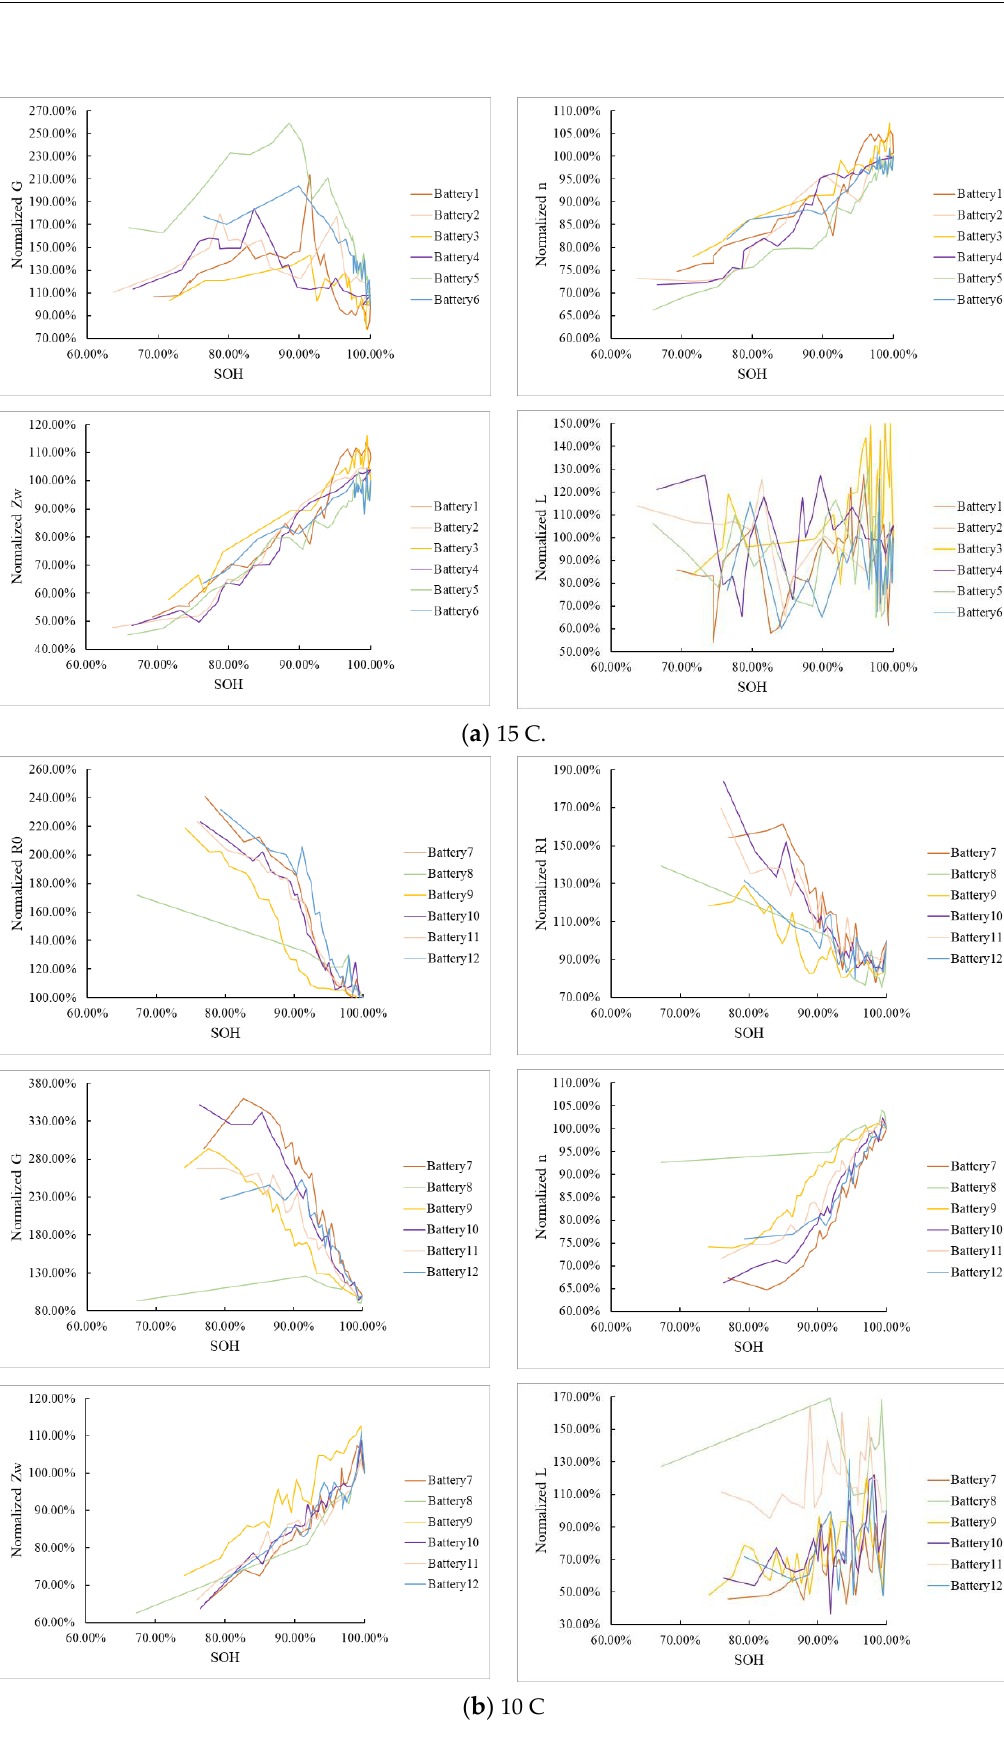
Figure A2. The relationship between the SOH and six normalized battery parameters (normalized according to the initial value).